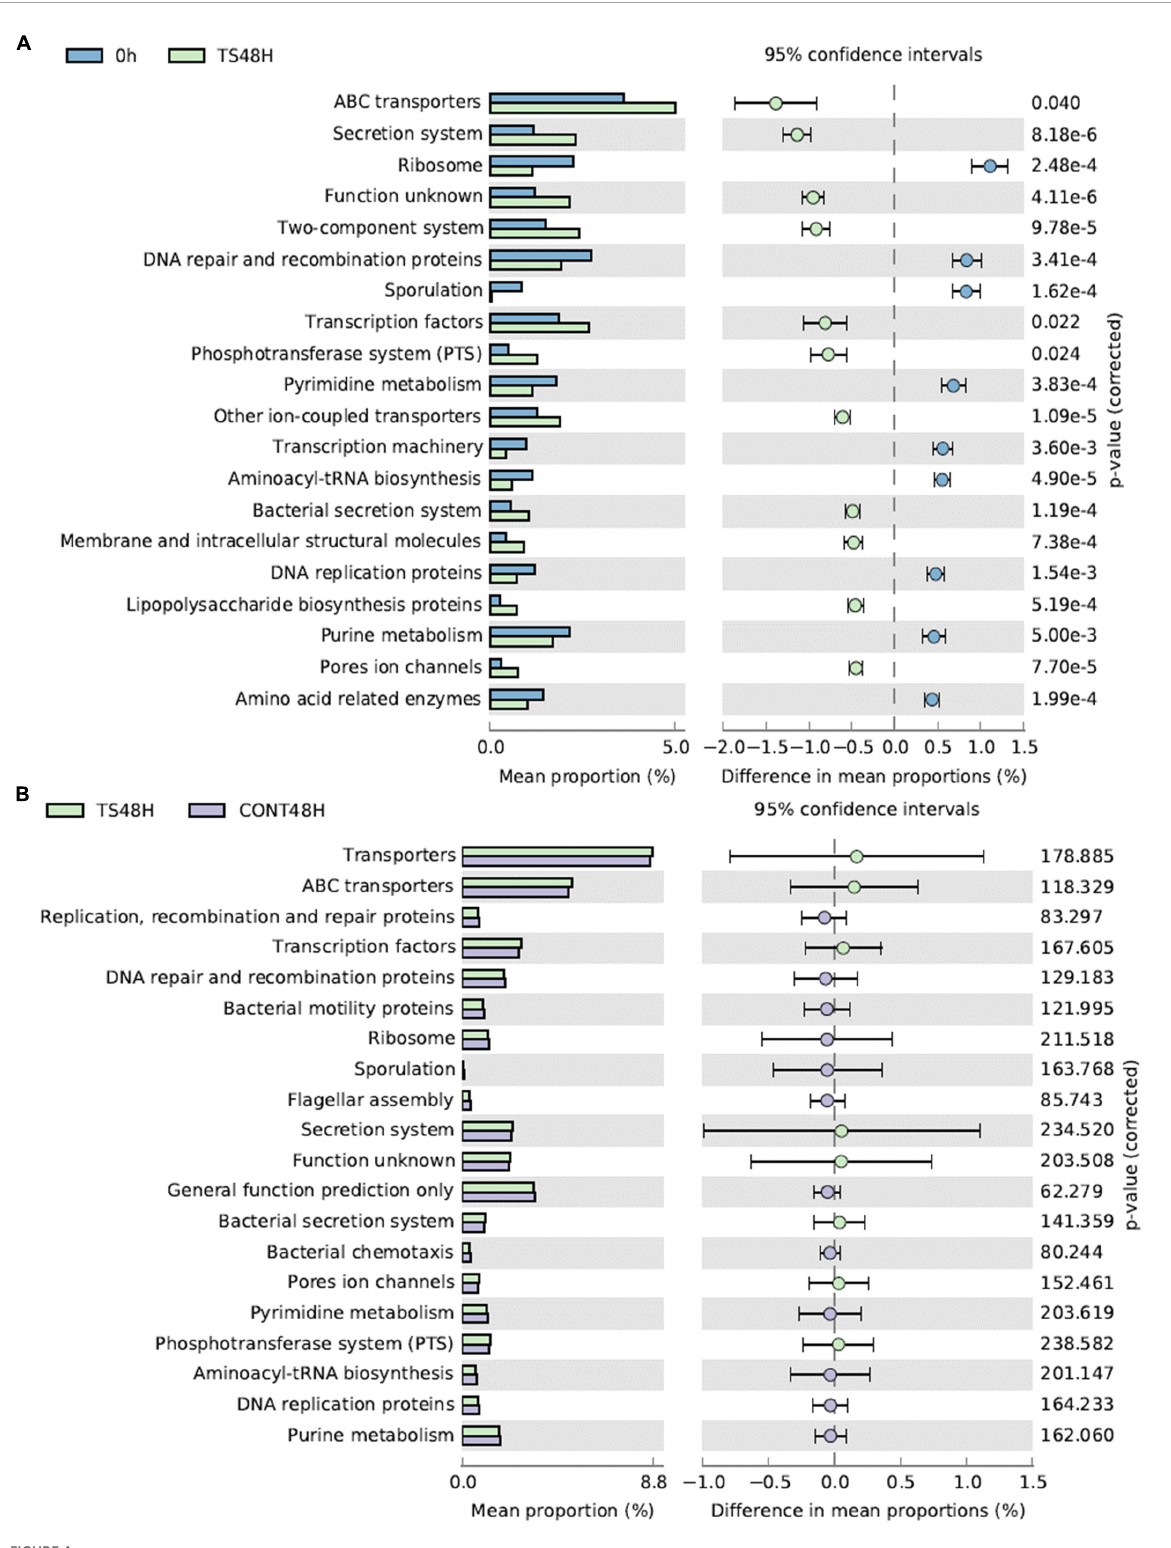
FIGURE4 Main metabolic functions comparing Talitrus saltator added samples at 48 h of fermentation with respect to baseline (A) and with respect to negative control samples at 48 h (B) . CONT, Negative controls; TS, T. saltator .